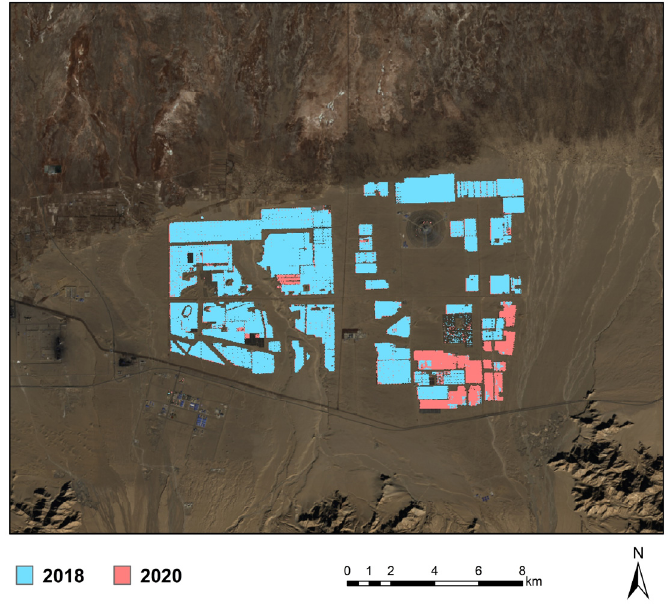
Figure 11. Image exhibiting the dynamics in areas occupied by PV plants in the east of the Golmud region from 2018–2020.